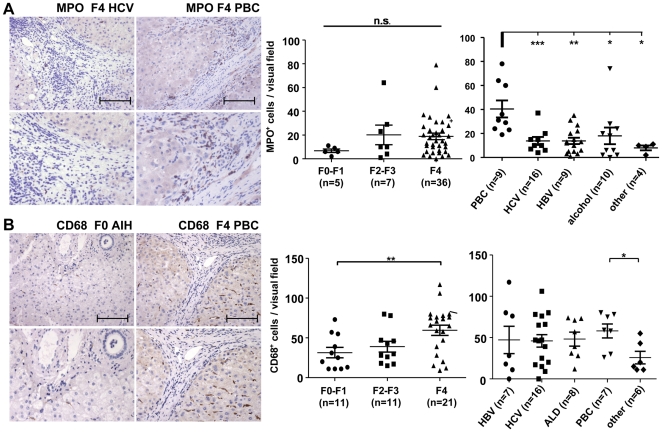
Immunohistochemical analysis of neutrophil and macrophage accumulation in chronic liver disease.(A) Myeloperoxidase (MPO) staining was performed to detect neutrophils within the liver. Upper panels depict representative images of neutrophil accumulation in PBC (left column) and HCV (right column) with F4 fibrosis at 200× magnification, lower panels magnify the periportal region of upper panels. MPO-positive neutrophils accumulate in PBC in comparison to ALD, HCV and HBV, whereas degree of fibrosis was not indicative for neutrophil count within the liver. Neutrophil cell infiltrate predominate within the cirrhotic fibres in periportal regions whereas remaining parenchyma was absent for neutrophil invasion. (B) CD68+ cells indicating macrophages accumulate according to severity of liver disease irrespective of underlying etiology. Images represent exemplarily distribution of CD68+ in F0 fibrosis (AIH) and F4 fibrosis (PBC). Scale bars represent 100 µm. AIH, autoimmune hepatitis; PBC, primary biliary cirrhosis; ALD, alcoholic liver disease.